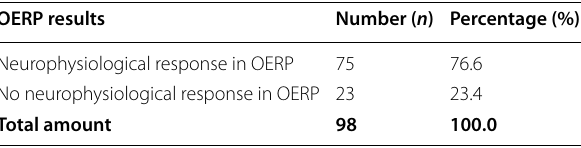
Table 5 Olfactory results of the cases as reported by the